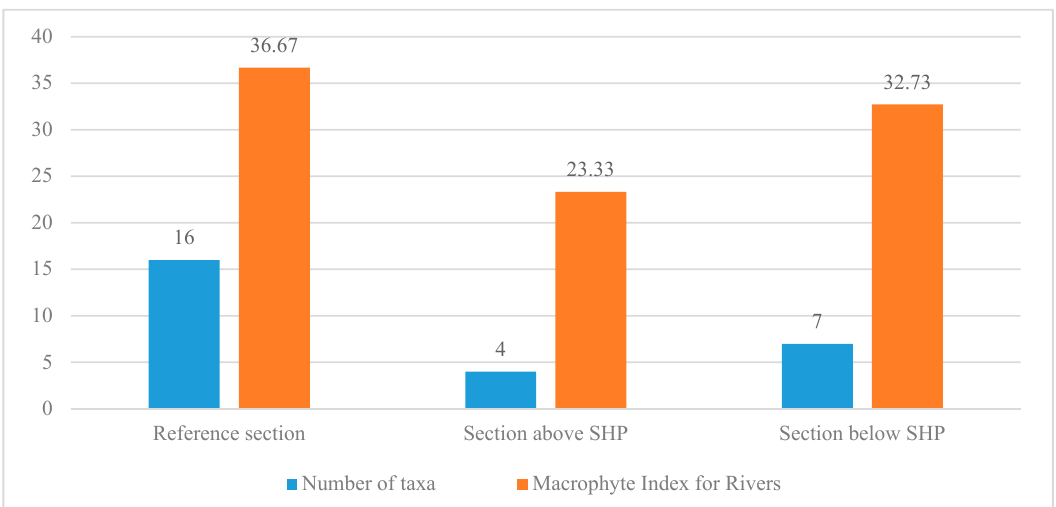
Figure 2. Number of taxa and MIR in individual research sections, the Ś l ę za, May 2017.